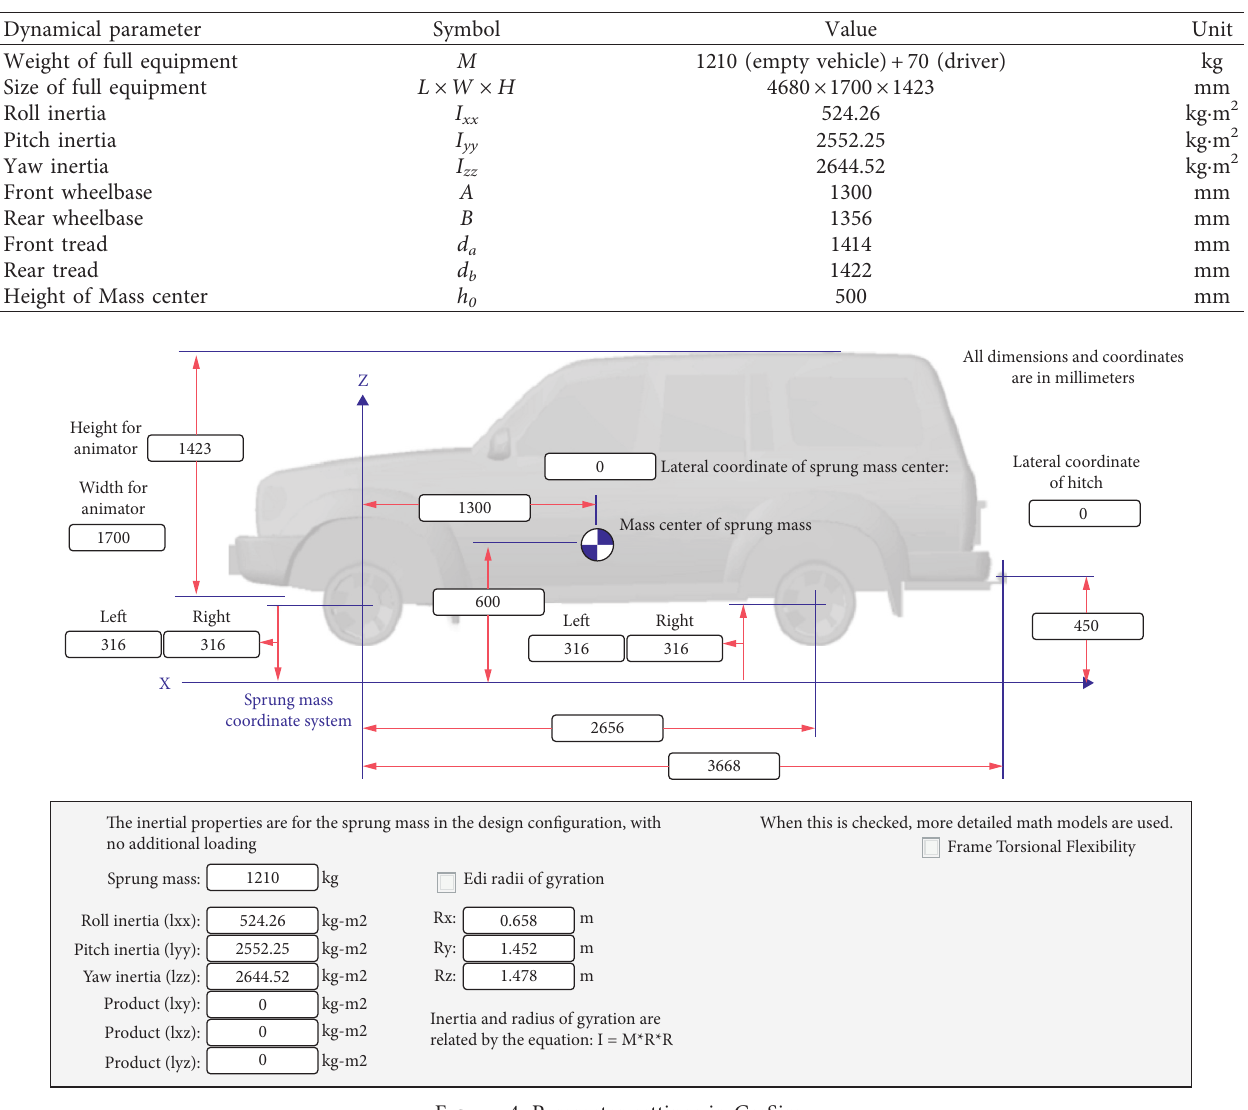
Table 1: Structure parameters of vehicle.